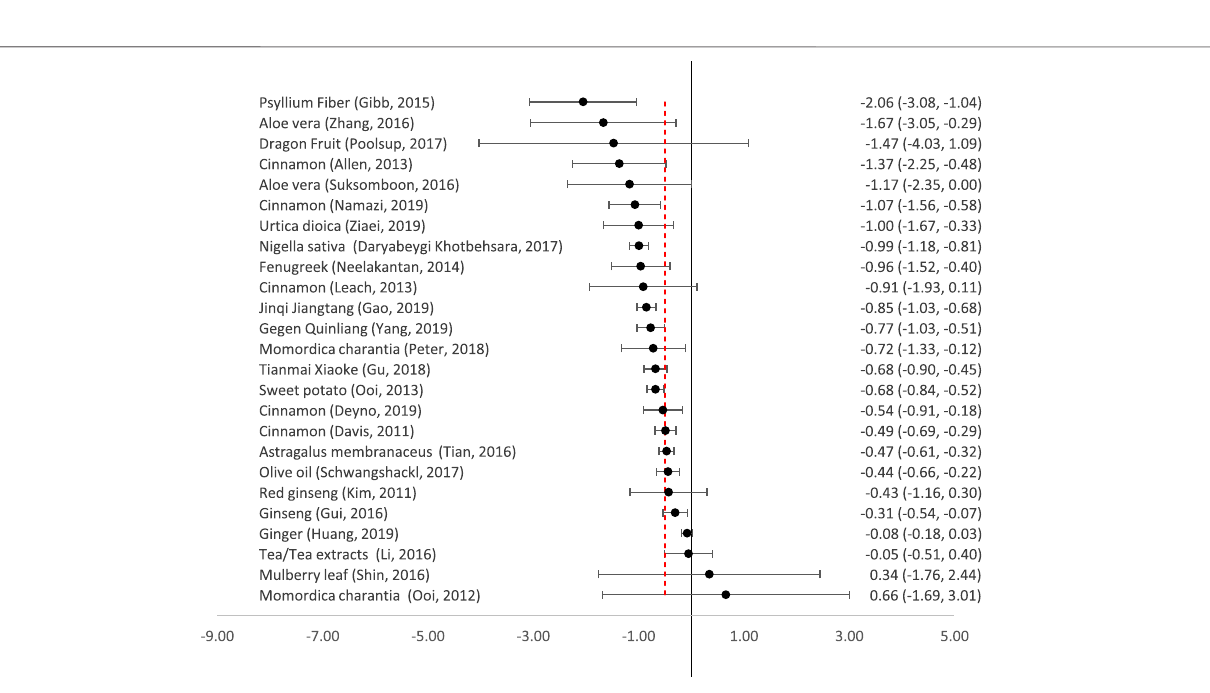
Frontiers in Pharmacology |